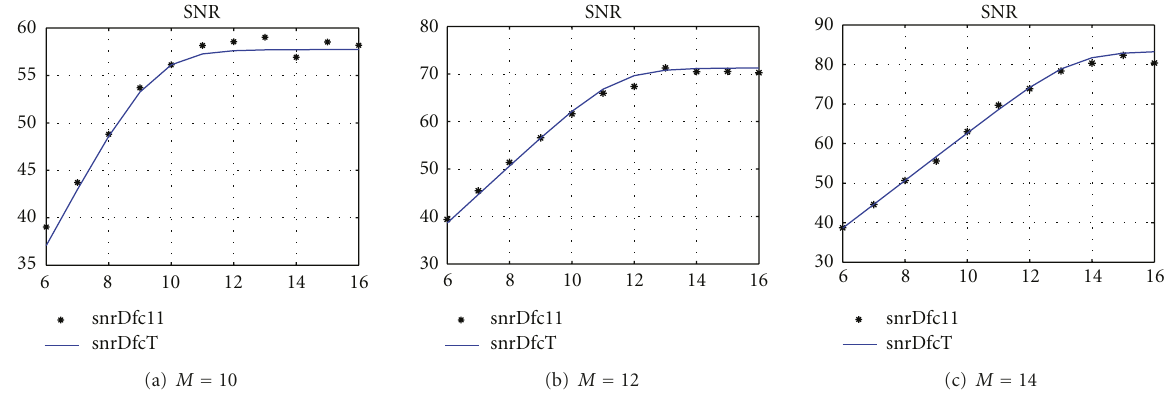
Figure 9: SNR variation with L for our solution with N =